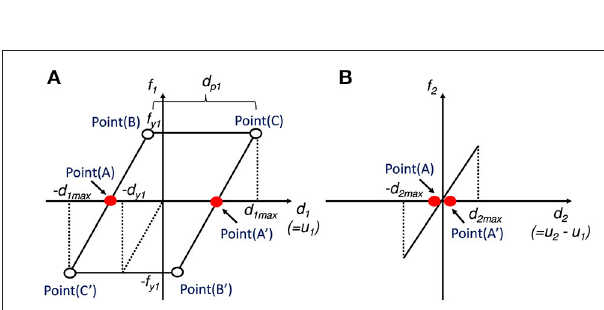
FIGURE 2 | Transition points in first-story restoring force-interstory drift relation and second-story restoring force-interstory drift relation together with multiple impulse timing, (A) Restoring force-interstory drift relation in first story, (B) Restoring force-interstory drift relation in second